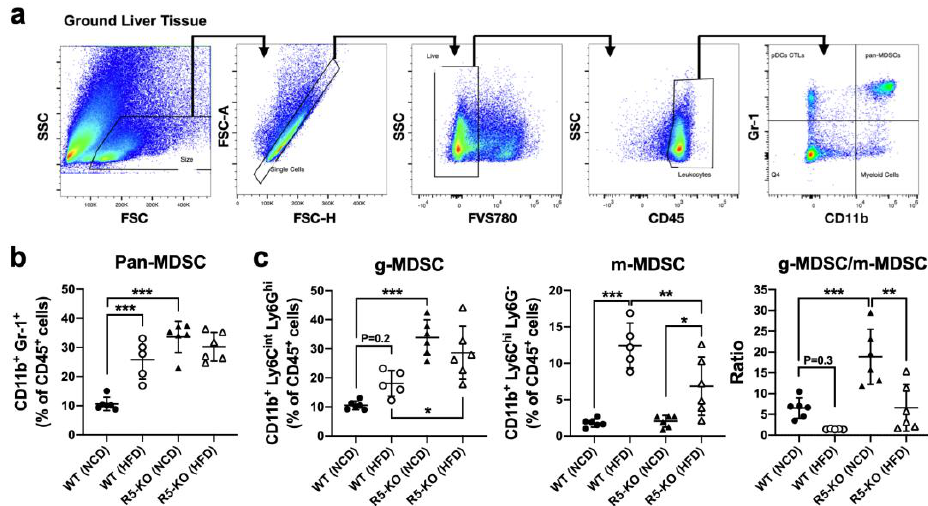
Figure 2. Global CCR5 deficiency elevates the hepatic g-MDSC population in both lean and obese mice. ( a ) Gating strategy for immunophenotyping hepatic MDSCs via flow cytometry. Percentages of hepatic MDSCs ( b ) and their subsets among the hematopoietic population ( c ) were distinguished. Representative and quantified results (means ± SD) are shown for the indicated number of mice. *,